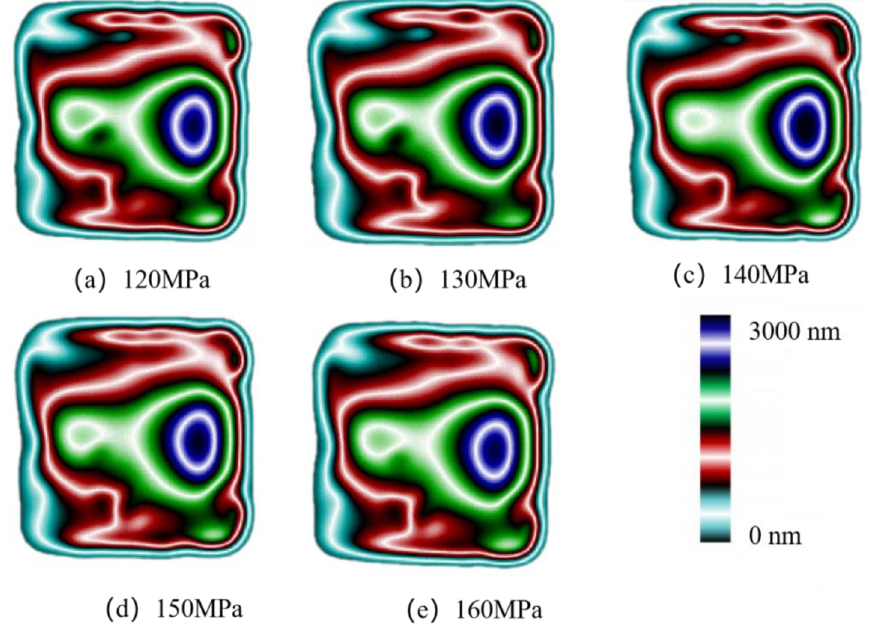
Figure 11. Birefringence distributions at different packing pressures.